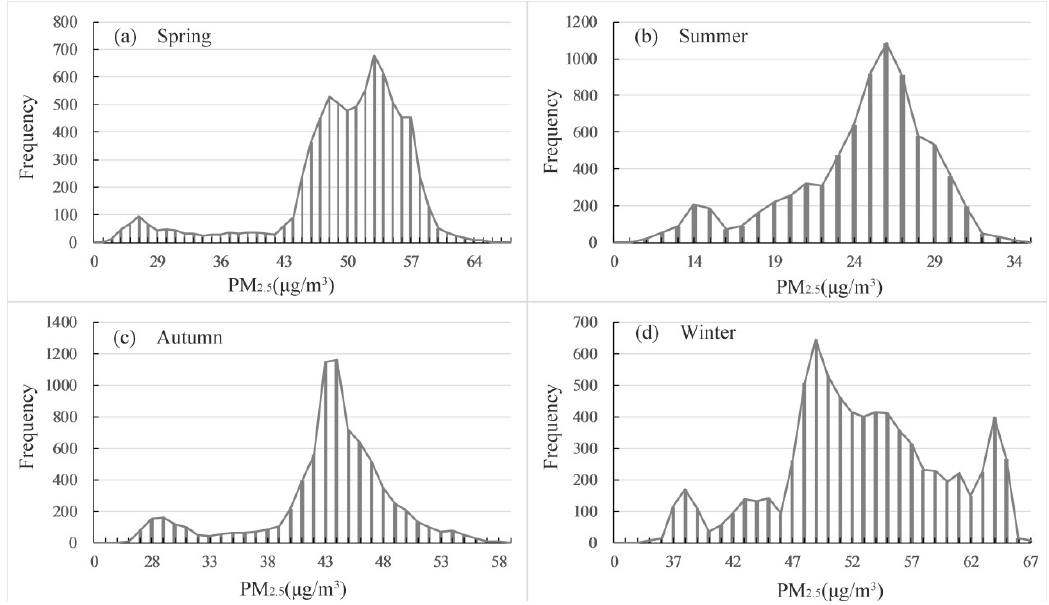
Figure 5. Histograms depicting PM 2.5 concentration statistics for four seasons in Hangzhou. ( a ) Spring; ( b ) Summer; ( c ) Autumn; ( d ) Winter.